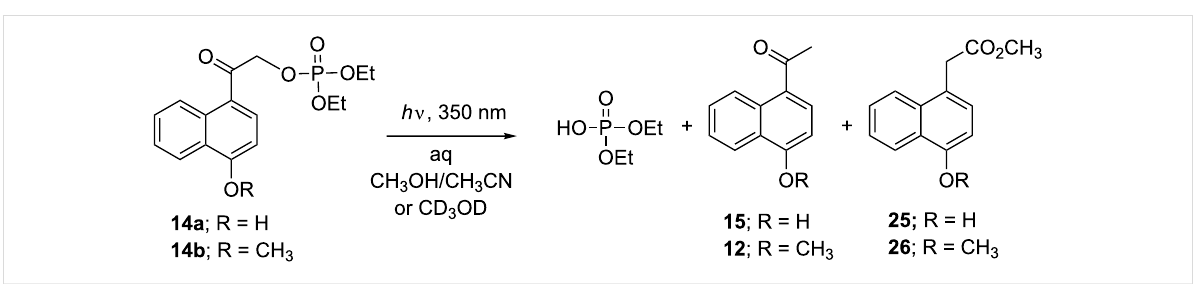
Table 1: Photolysis efficiencies and product yields for 1,4-HNA DEP ( 14a ) and 1,4-MNA DEP ( 14b ). ester % conversion a deprotection Φ disc % yield b 14a OH 98 100 0.028 14b OMe 40 90